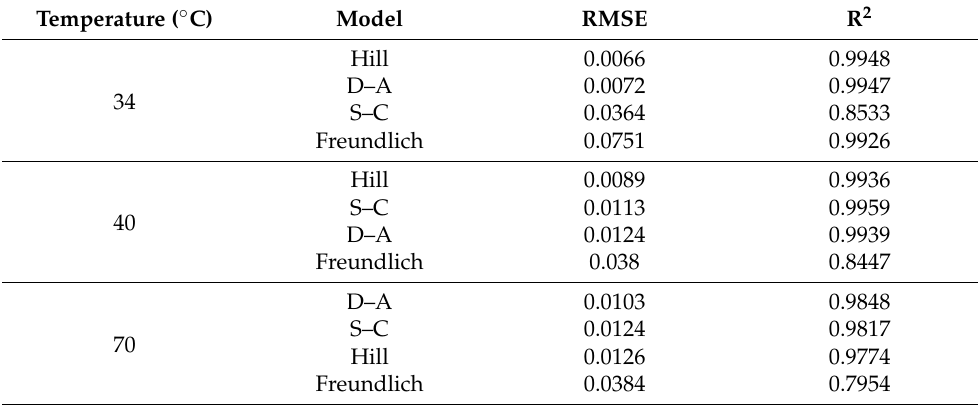
Table 3. Errors and statistical analysis of isotherm fitting